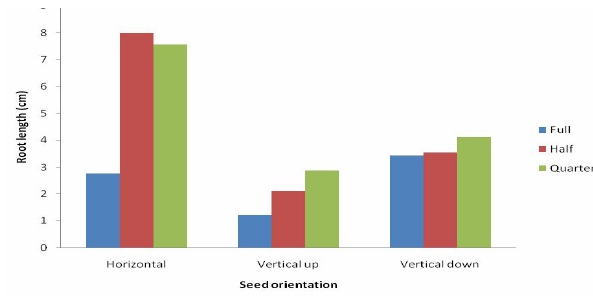
Fig. 2. Effect of seed orientation and medium strengths on root length (cm) of Pterocarpus marsupium Root